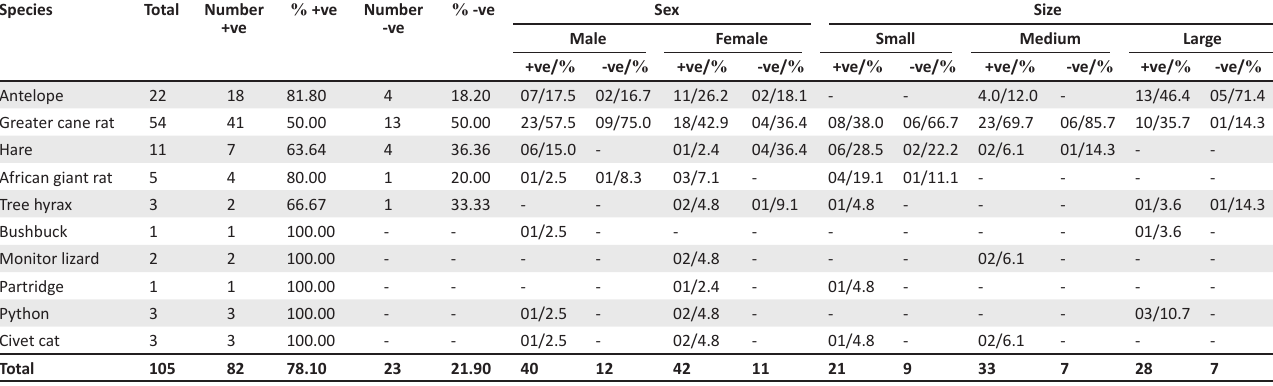
TABLE 2: The prevalence of Leptospira organisms in 105 kidneys of wildlife in Ellinghausen McCullough Johnson Harris medium according to sex and size. Species